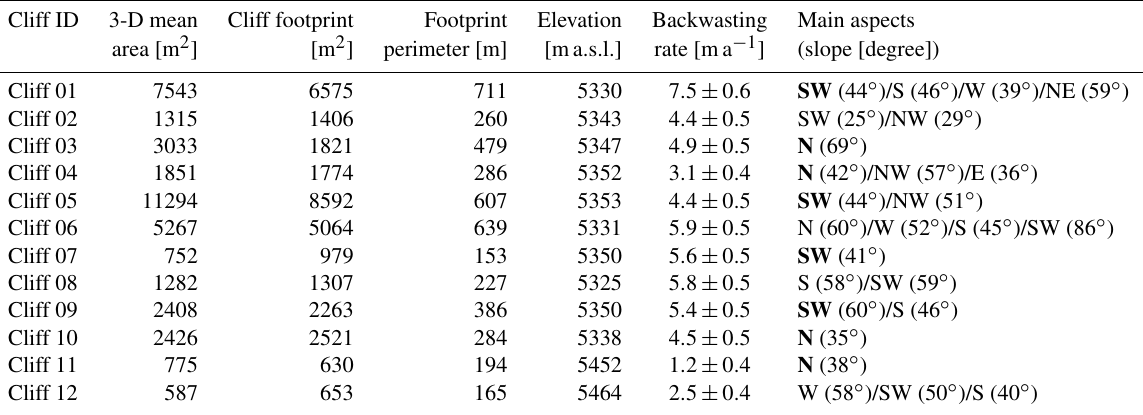
Table 1. Characteristics of the 12 surveyed cliffs. The 3-D mean area was calculated as the mean of the November 2015 and 2016 areas, which were measured from the PCs obtained with the terrestrial photogrammetry on CloudCompare. The perimeter was calculated from the cliff footprint of November 2015 and 2016. The backwasting rate was calculated as the ratio between the cliff backwasting volume obtained from terrestrial photogrammetry and the 3-D mean area, for the period November 2015–November 2016. The cliffs are usually not perfectly planar and they exhibit multiple aspects. The main aspects were calculated by fitting a plan through the cliff PC or through parts of the PC in CloudCompare. The main aspect is in bold when it was possible to determine